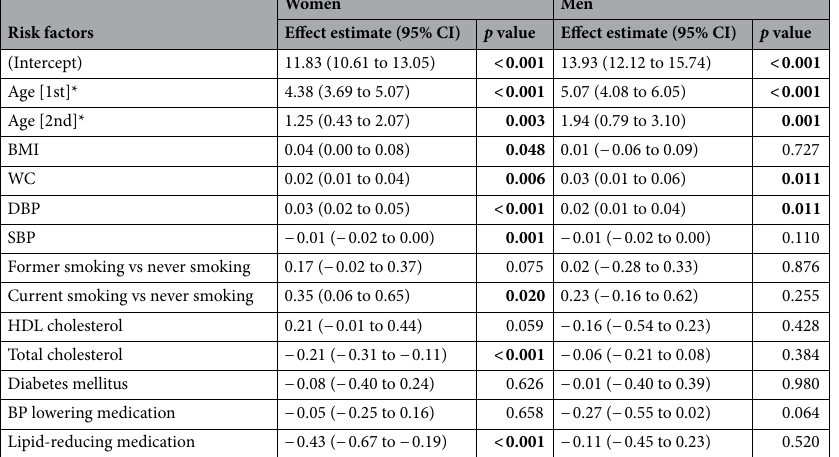
Table 3. Associations between cardiovascular risk factors and absolute infrarenal aortic diameter among women and men. BMI body mass index, WC waist circumference, BP blood pressure, DBP diastolic blood